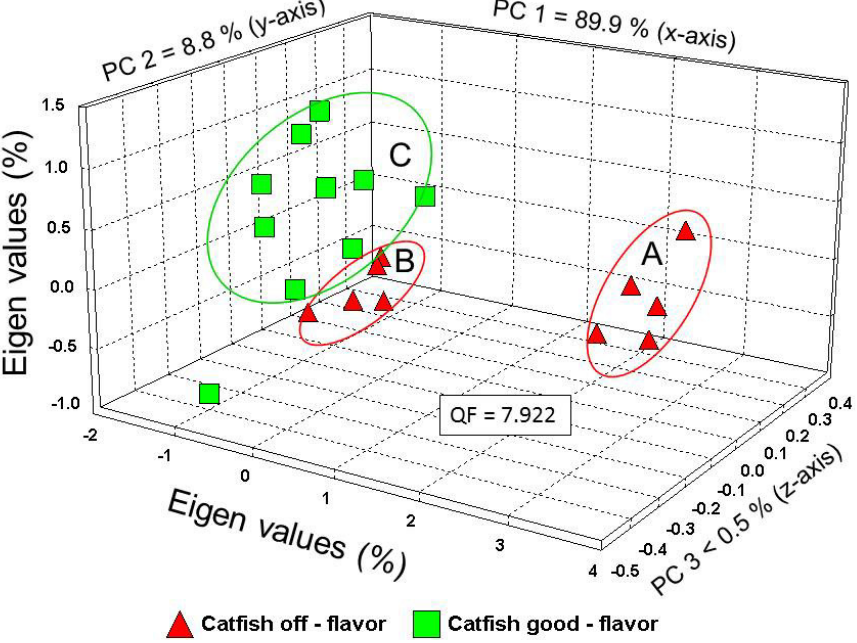
Figure 3. Aroma map of headspace volatiles from good-flavor vs. off-flavor catfish meat samples (aroma classes) based on principal component analysis (PCA). The percentages of the total variance, accounting for the variability explained by each orthogonal principal component (PC), are as follows: PC 1 = 88.9%, PC 2 = 8.8%, and PC 3 < 0.5%. The Quality Factor (QF) value of significant difference between the aroma profiles of good-flavor vs. off-flavor catfish meat samples was QF = 7.922, indicating a significant statistical difference between these two aroma classes at P <